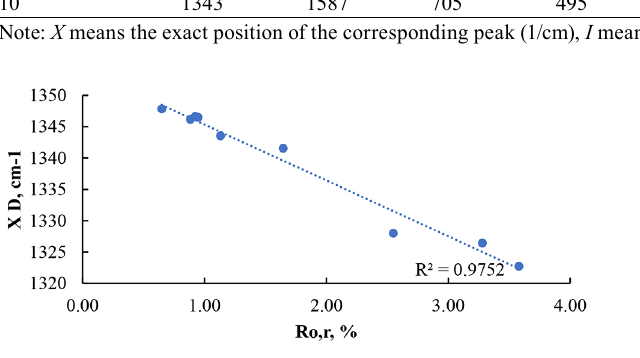
Fig. 7 Correlation between the “D” band peak location and coals vitrinite reflectance